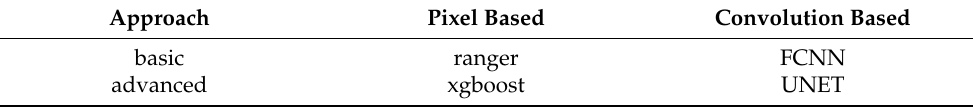
Table 1. Overview of modeling